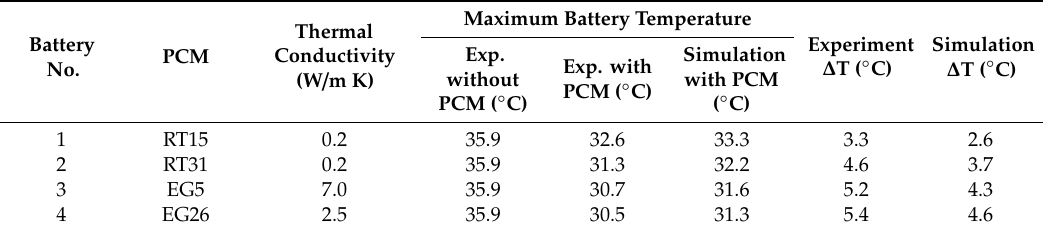
Table 4. Comparison of T max for simulation and experiment discharge rate of 1 C, 1 / 2 C, and 1 / 4 C.